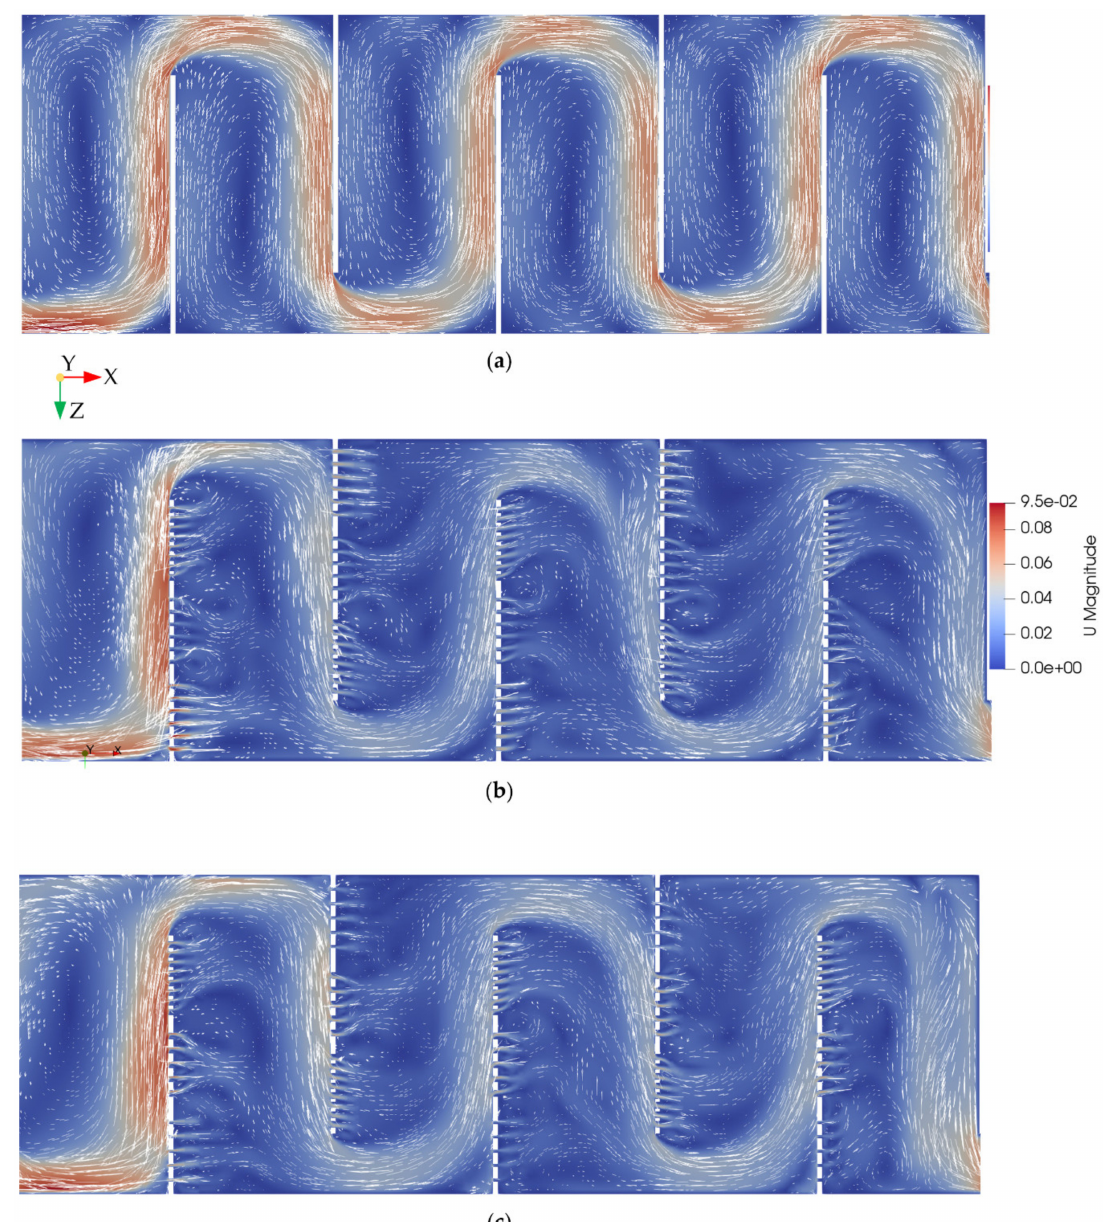
Figure 7. Velocity vectors on a horizontal plane located at the mid-depth of the tank: ( a ) conventional design; ( b ) Design 2; ( c ) Design